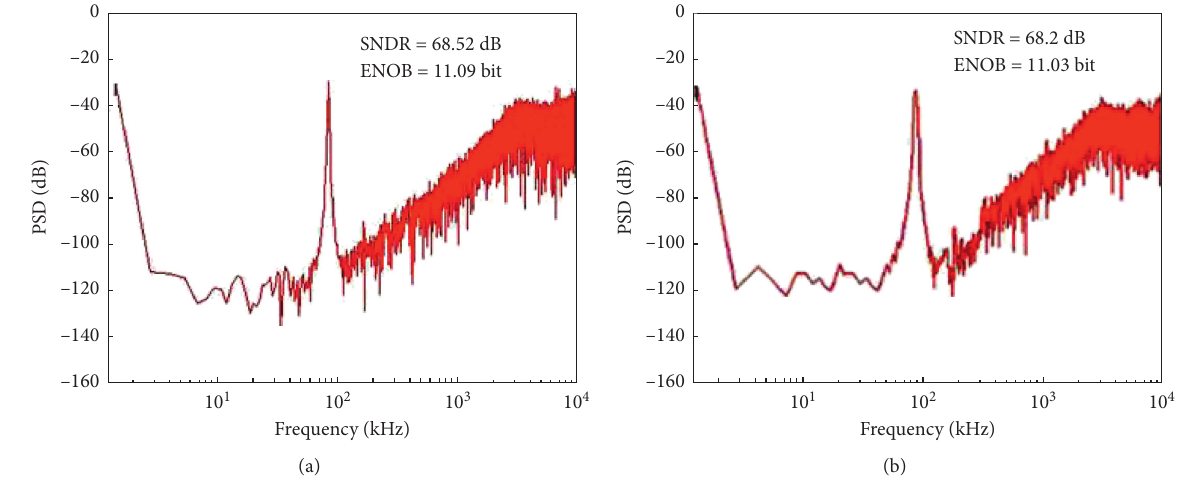
Figure 9: Output spectrum results: (a) input frequency is 80kHz; (b) input frequency is 110kHz.